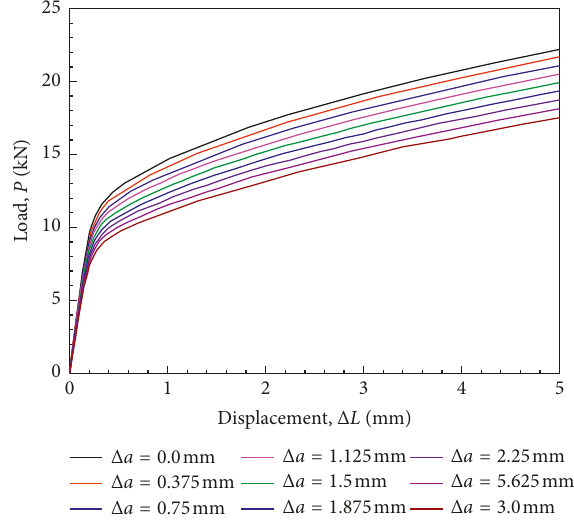
Figure 5: The relationship between tensile load and load line displacement. numerical simulation results. The green lines are used to represent the intersection of numerical simulations and test results. By extracting the intersection of these curves, we can